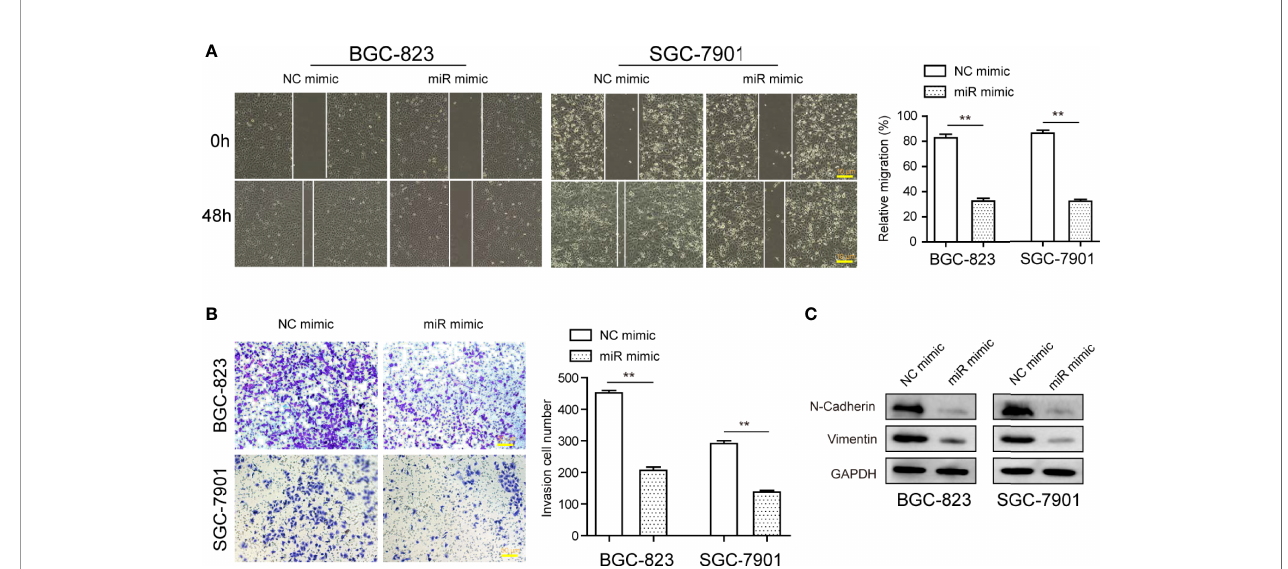
FIGURE 4 | The in fl uence of miR-1224 on the invasion and migration of BGC-823 and SGC-7901 cells. (A) Overexpression of miR-1224 reduced the migration of GC cells. (B) Ectopic expression of miR-1224 depressed the invasion of GC cells. (C) The protein expression of N-cadherin and vimentin was measured with Western blot assays. ** p < 0.01. Experiments were repeated three times with three